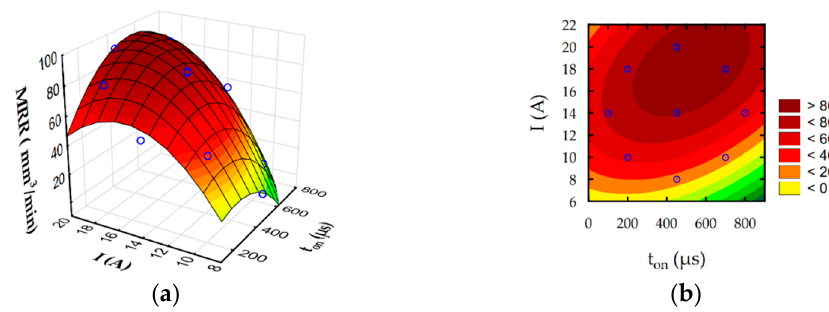
Figure 14. Estimated for MRR: ( a ) response surface and ( b ) contour plot.